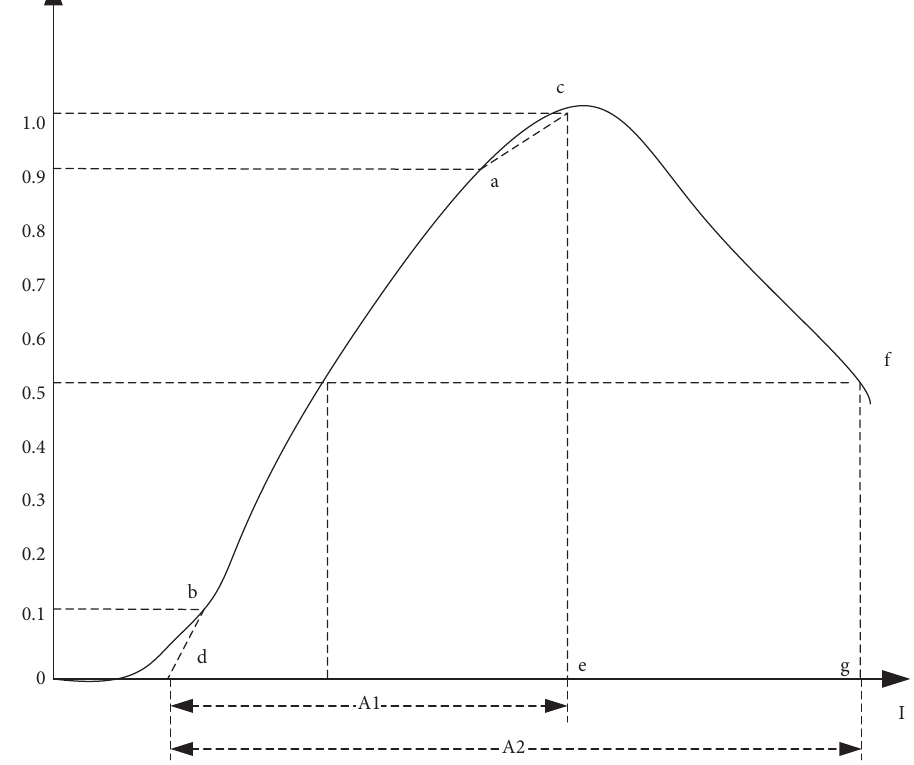
Figure 2: Lightning waveform.